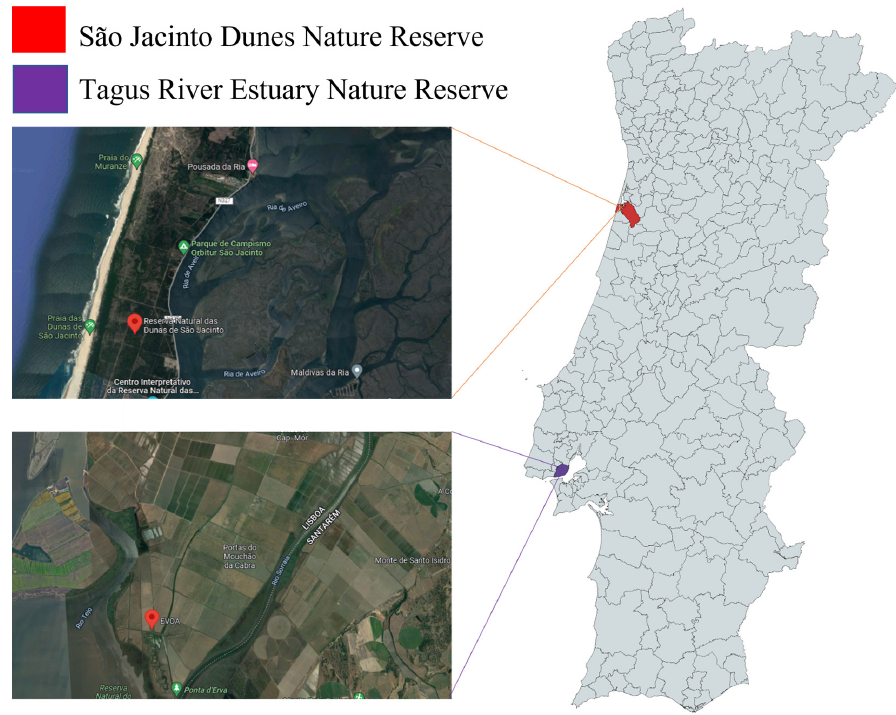
Figure 1. Selected sampling locations (city of Porto and Aveiro) in Portugal used in this study.